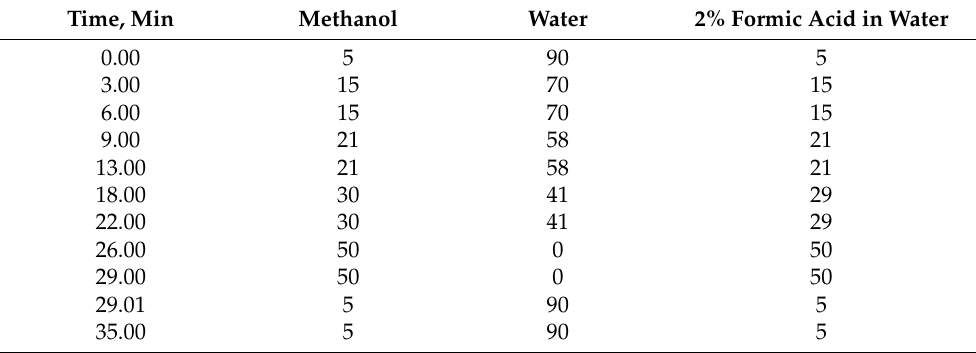
Table 6. LC-MS mobile phase